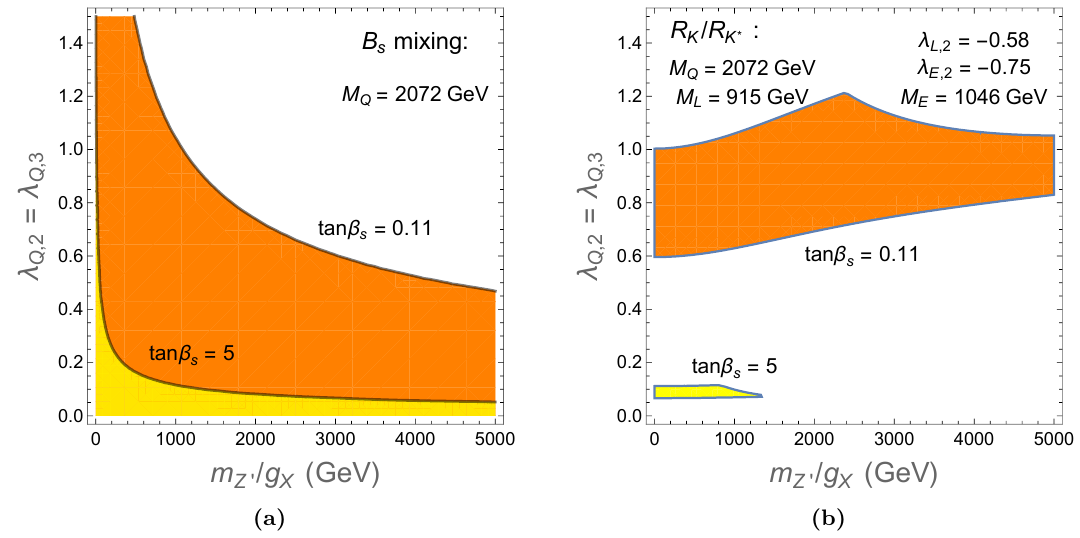
Figure 1. (a) The parameter space consistent with constraints from B s mixing in the ( m Z 0 =g Z , (cid:21) Q; 2 = (cid:21) Q; 3 ) plane for two choices of tan (cid:12) S : tan (cid:12) S = 0 : 11 in orange and tan (cid:12) S = 5 in yellow. (b) The impact of the R K =R K (cid:3) constraints on the C (cid:22) and (3.5)) in the same plane, for the same two choices of tan (cid:12) S